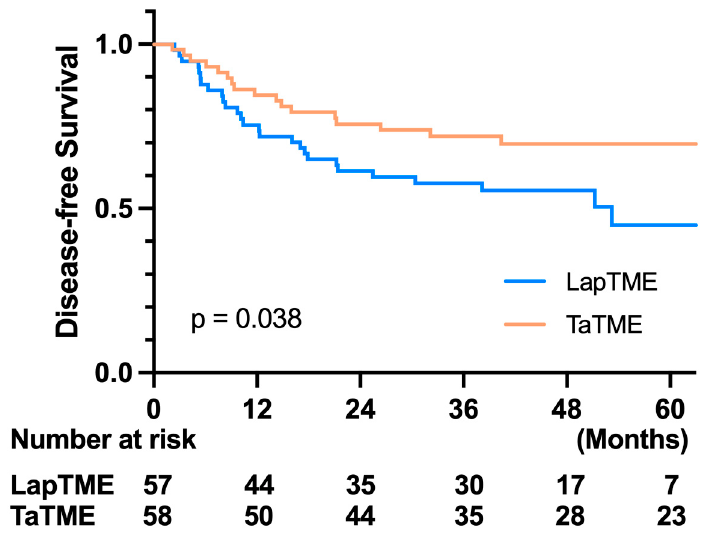
Figure 3. Kaplan–Meier survival curves of DFS between the TaTME and LapTME groups.